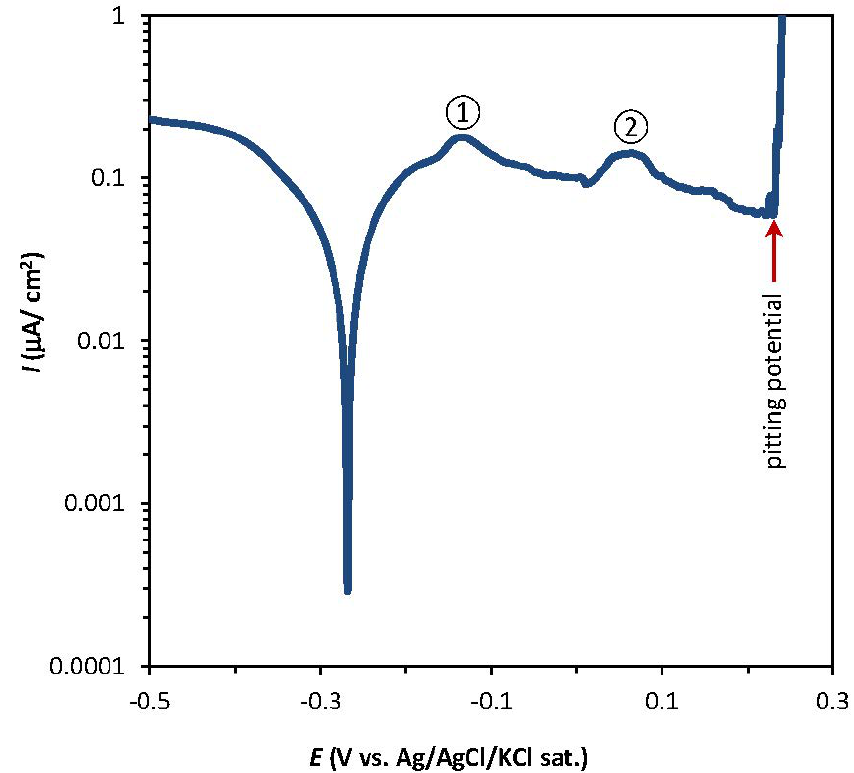
Figure 1. Potentiodynamic polarization curve of pure copper in 3.82 M NaCl (pH = 9.8) obtained using a microcapillary with a tip diameter of ~100 µm. The numbers 1 and 2 indicate the position of the peaks representing the formation of Cu(I) and Cu(II),